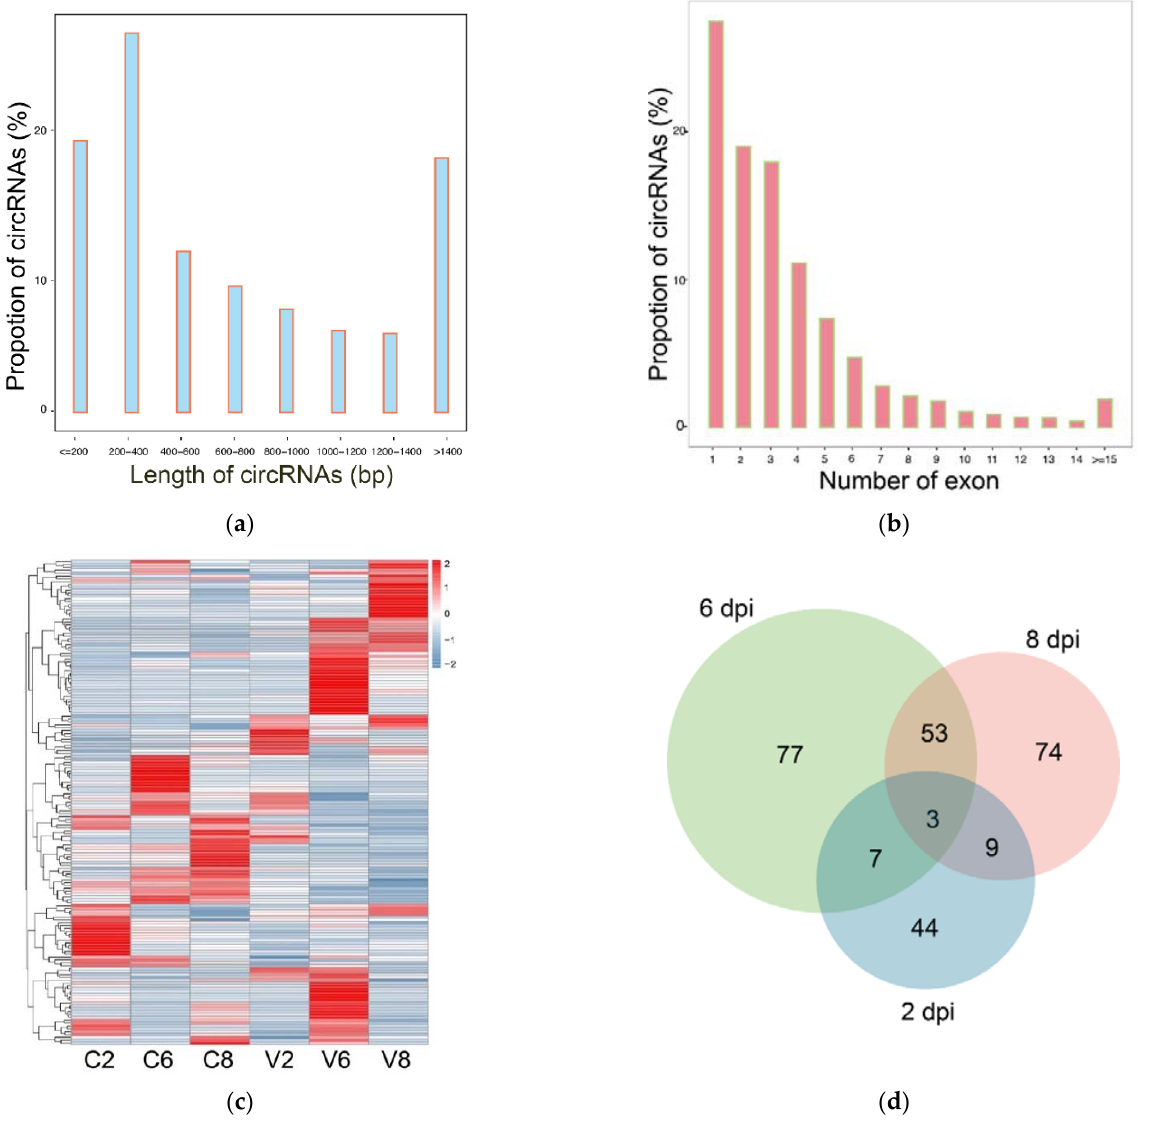
Figure 6. Analysis of circular RNA (circRNA) sequencing data. ( a ) The length distribution of circRNAs; ( b ) The exon number of circRNAs; ( c ) The heatmap of DEcircR expression profiles in different groups at different time points. For convenience, “C2”, “C6”, and “C8” indicate the control groups at 2, 6, and 8 dpi, respectively; “V2”, “V6”, and “V8” indicate megalocytivirus-infected groups at 2, 6, and 8 dpi, respectively; ( d ) Venn diagram showing the overlap of DEcircRs at 2 dpi (blue), 6 dpi (green), and 8 dpi (pink). Table 4. The number of up- and downregulated DEcircRs, at 2, 6, and 8 days post infection (dpi). Time Point